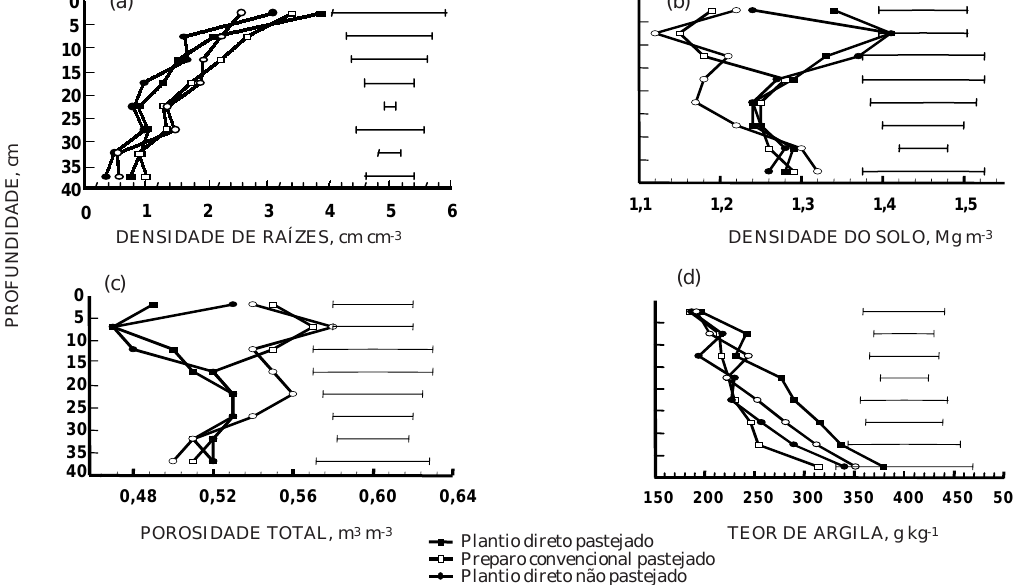
Figura 3. Densidade de raízes (a), densidade do solo (b), porosidade total (c) e teor de argila (d), ao longo da profundidade, em solo sob plantio direto e preparo convencional, ambos anteriormente com e sem pastejo. Linhas horizontais indicam a diferença mínima significativa a 5% (DMS) e comparam médias dos tratamentos em cada